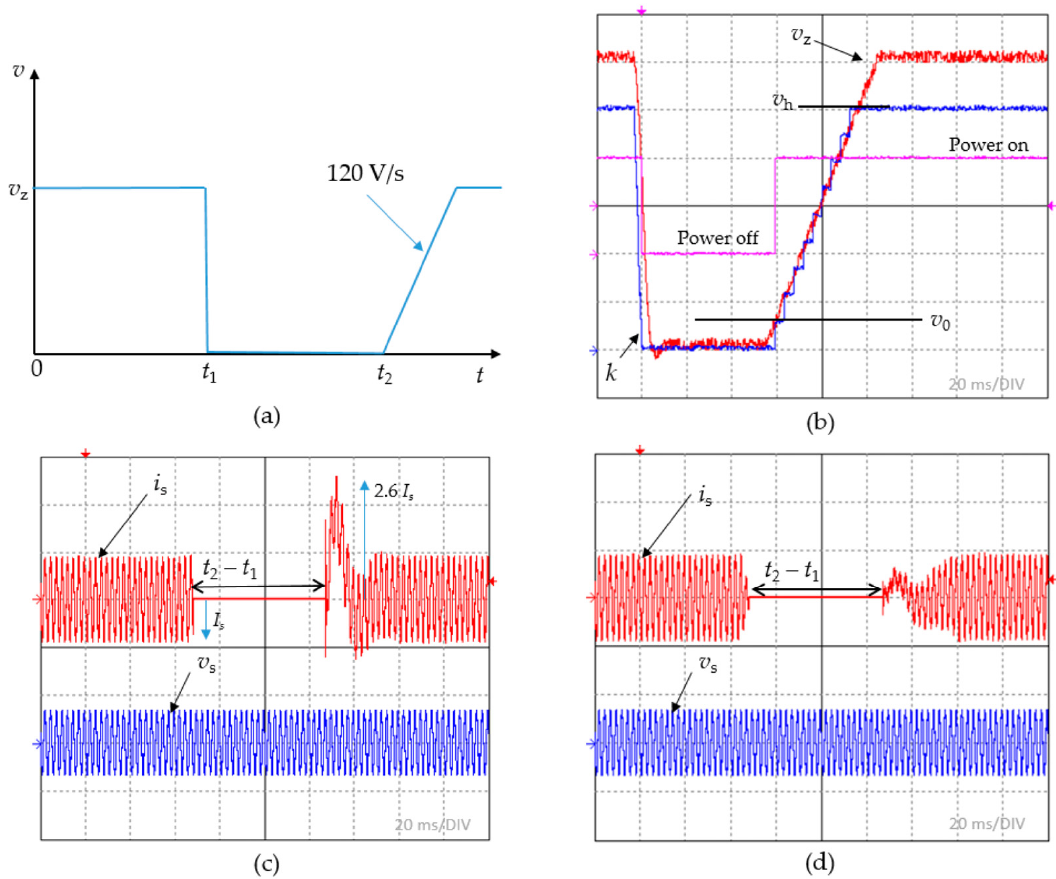
Figure 6. Dynamic response of the system to a voltage change on power bus 4: ( a ) assumed voltage profile on bus 4; ( b ) waveforms of the recorded voltage of bus 4 v z , correction factor k, and supply voltage identi fi er (pink color); waveforms of current i s and voltage vs. of bus 2 recorded in the classical system ( c ) and in the proposed system ( d ).